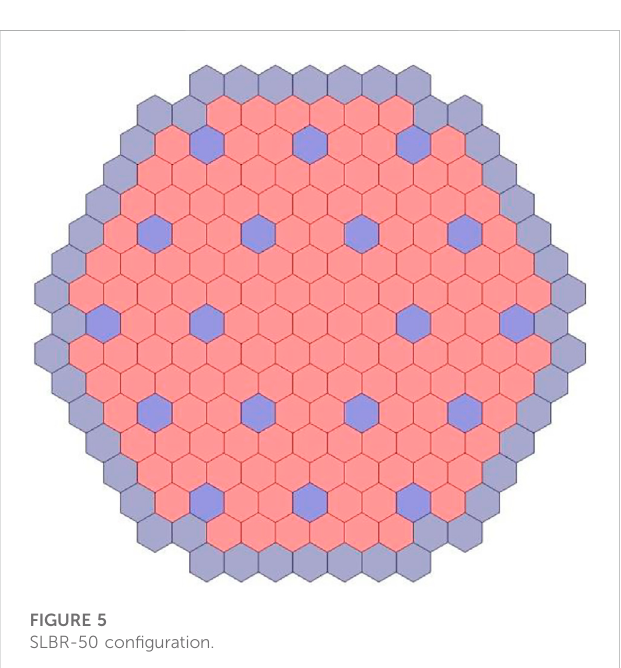
FIGURE 5 SLBR-50 con fi